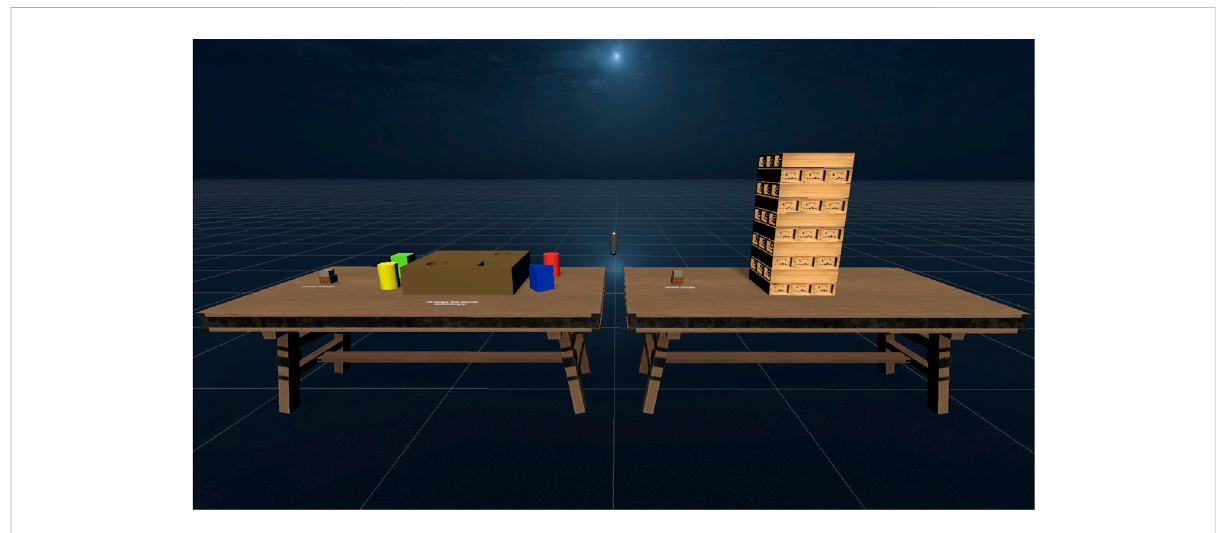
FIGURE 10 Performance experiment scene: both desktop and immersive